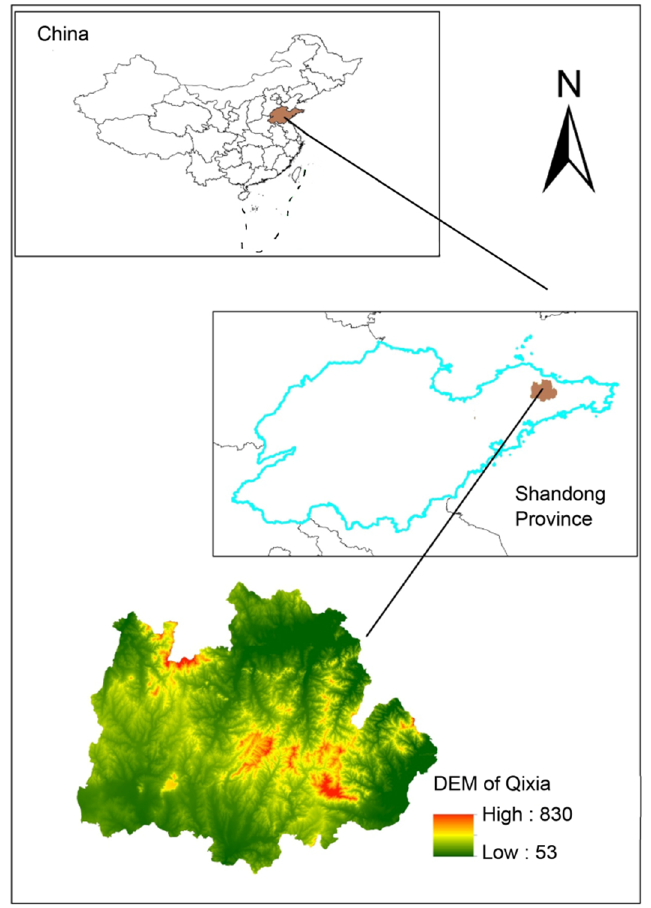
Figure 1. Above to below: location of Shandong Province in China, location of Qixia in Shandong Province, and Digital Elevation Model (DEM) of Qixia.